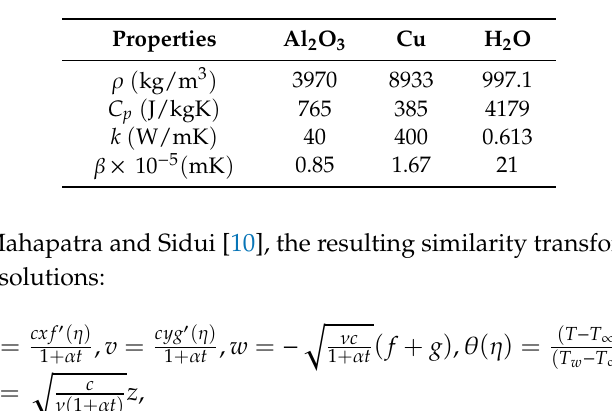
Table 2. Thermophysical properties of nanoparticles and base fluid (Oztop and Abu-Nada